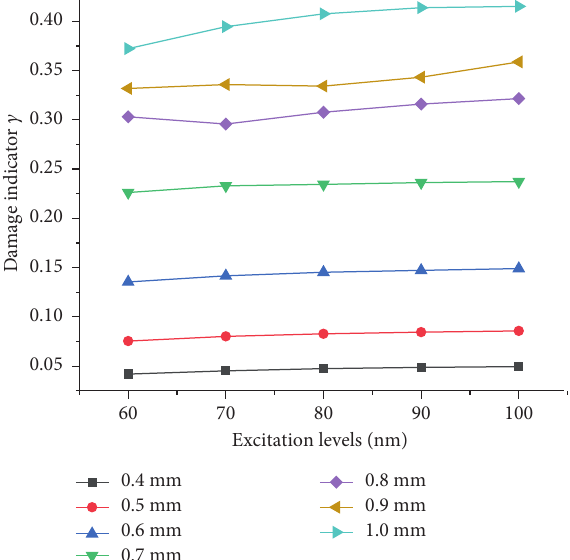
Figure 4: Damage indicator c for various crack lengths.